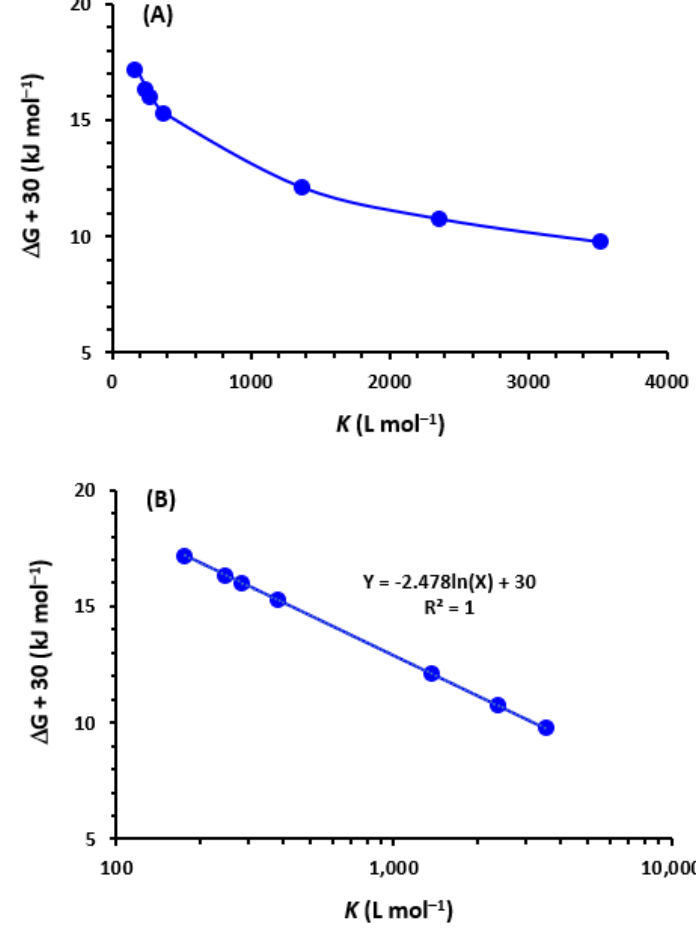
Figure 5. The association constant ( K ) versus free energy change ( ∆ G) for the CTC of TKIs with iodine. K values were presented in linear and logarithmic scale (panels ( A ) and ( B ), respectively). A value of 30 was added to all ∆ G values to convert their negative values to positive ones.